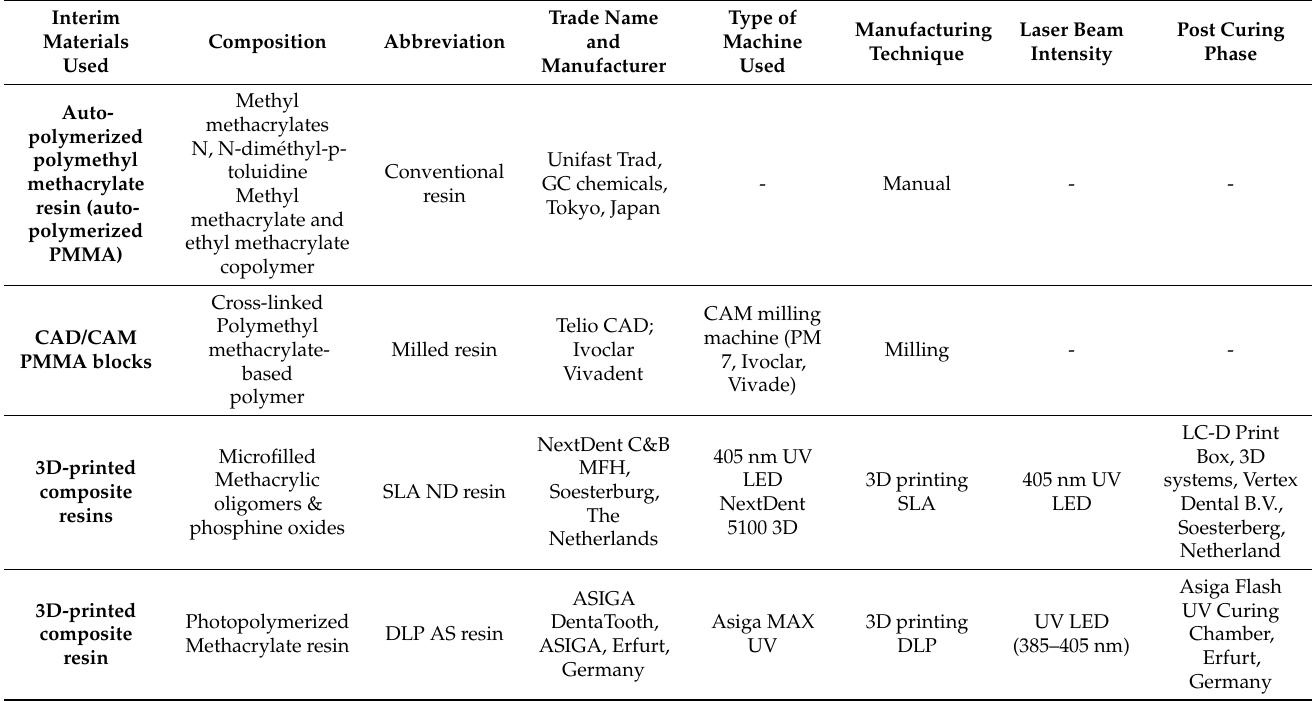
Table 1. Materials used in the current